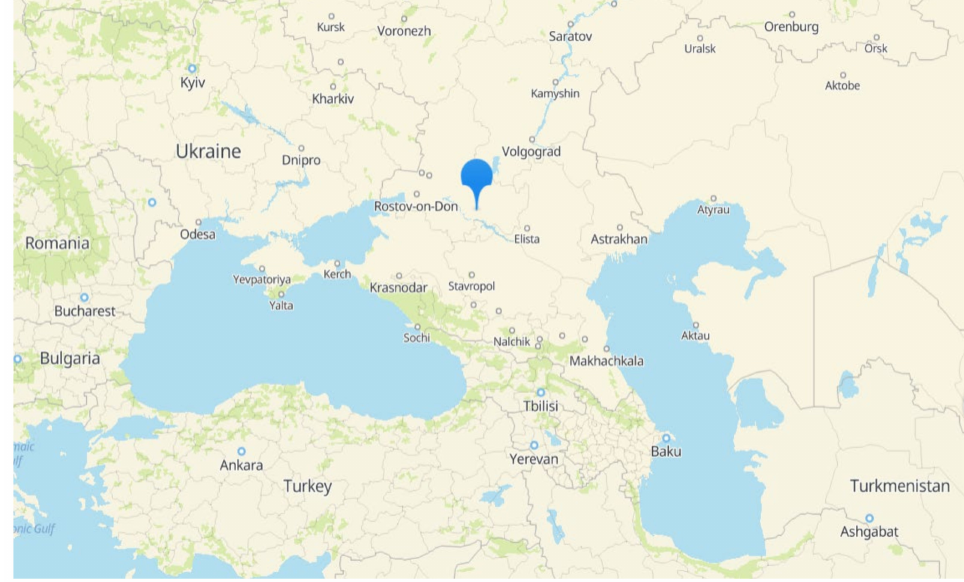
Figure 1. Kastanozem complex of the dry steppe South Russia in the Rostov Region (blue mark—the Kastanozem complex area geographical center). 2GIS. https://2gis.ae/geo/36.933956%2C46.209306? m=43.574236%2C42.265672%2F5.17 (accessed on 6 July